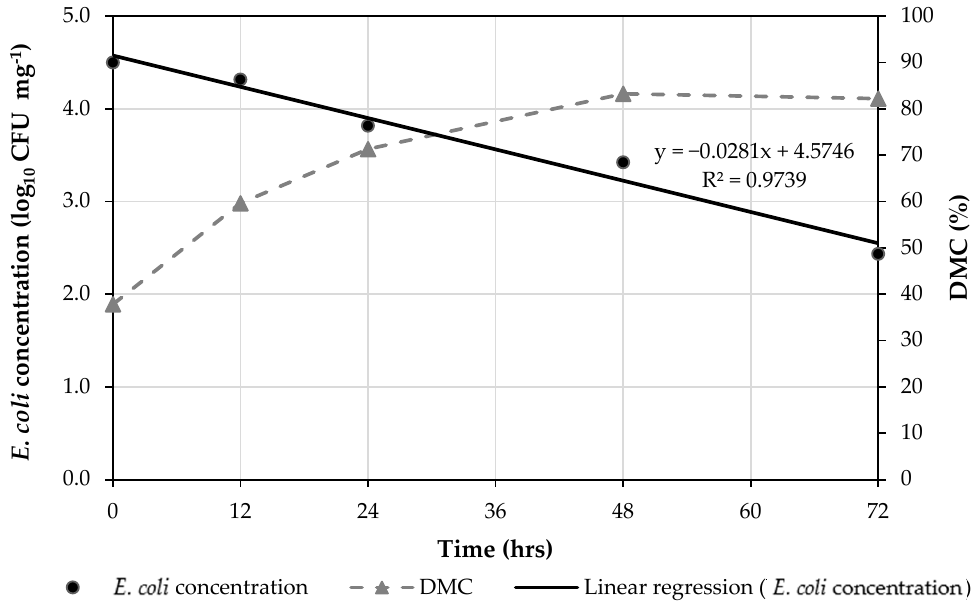
Figure 2. E. coli concentration and dry matter content (DMC) in poultry litter in a 72-h exposure under laboratory environmental condition (20.5 °C and 36%).